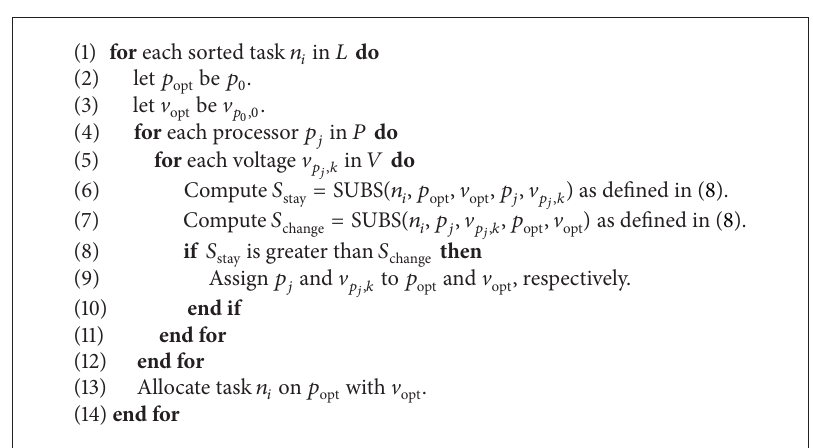
Algorithm 1: EECS heuristic outline.